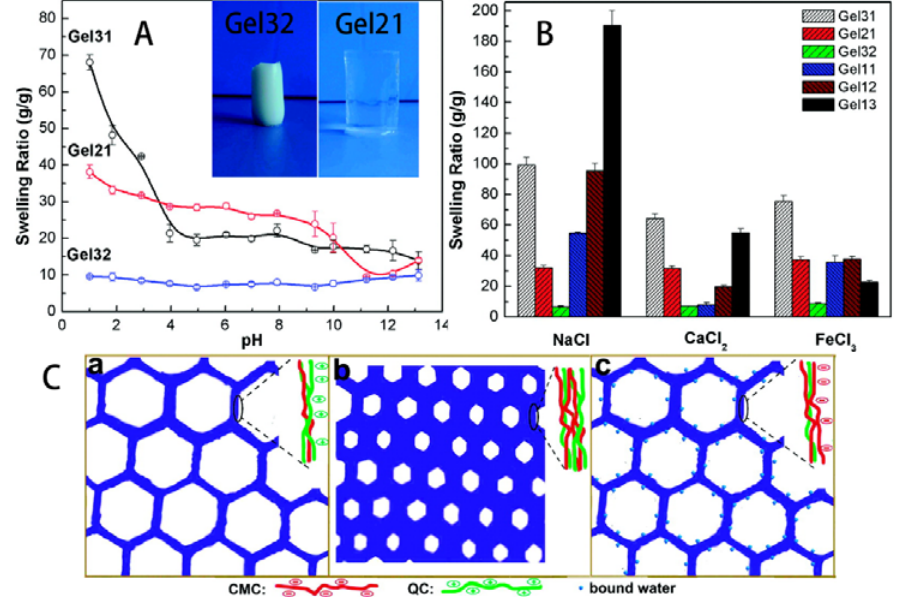
Figure 21. ( A ) Effects of pH on the swelling behaviors of QC/CMC hydrogels in buffer solutions; ( B ) Swelling ratio of hydrogels in different salt solutions (0.01 M): NaCl, CaCl ; and ( C ) Schematic illustrations of the structures of QC/CMC hydrogels: and FeCl 3 ( a ) Gel31; ( b ) Gel32; and ( c ) Gel13. Reprinted with permission from [44]. Copyright 2011 American Chemical